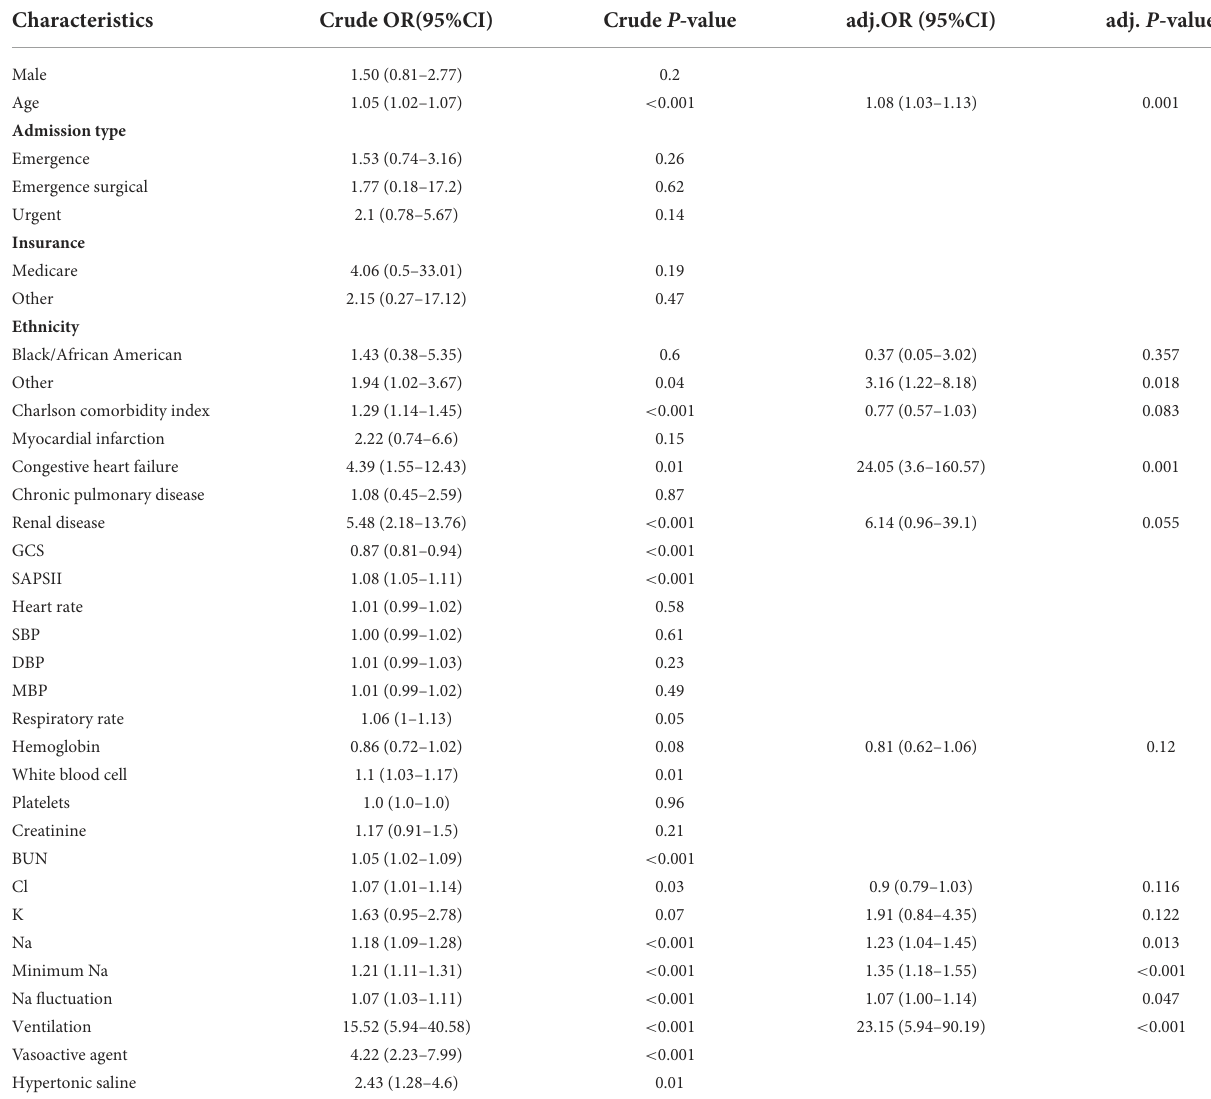
TABLE 2 Univariate and multivariate logistic analysis between serum sodium level and in-hospital mortality. Characteristics Crude